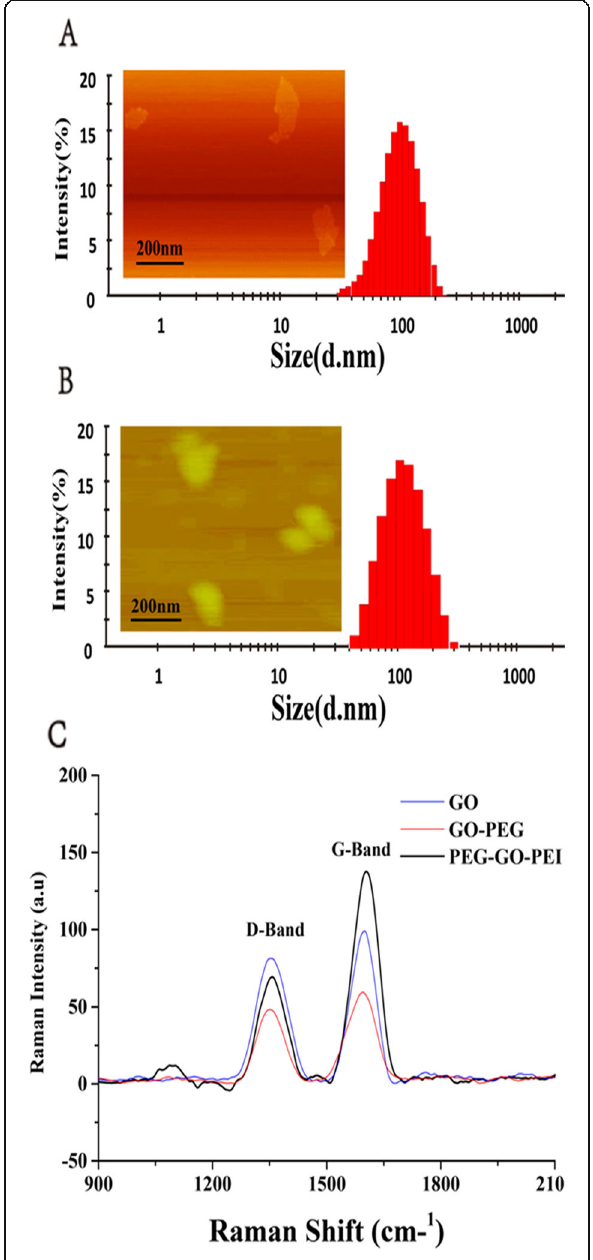
Fig. 2 The characterization of the nanoscale delivery system. Atomic force microscopy (AFM) and dynamic light scattering (DLS) were used for characterizing morphology and size distributions: a GO and b PEG-GO-PEI-FA. Raman spectra for the analysis of the generated graphene oxide surface of GO, GO-PEG, and PEG-GO-PEI